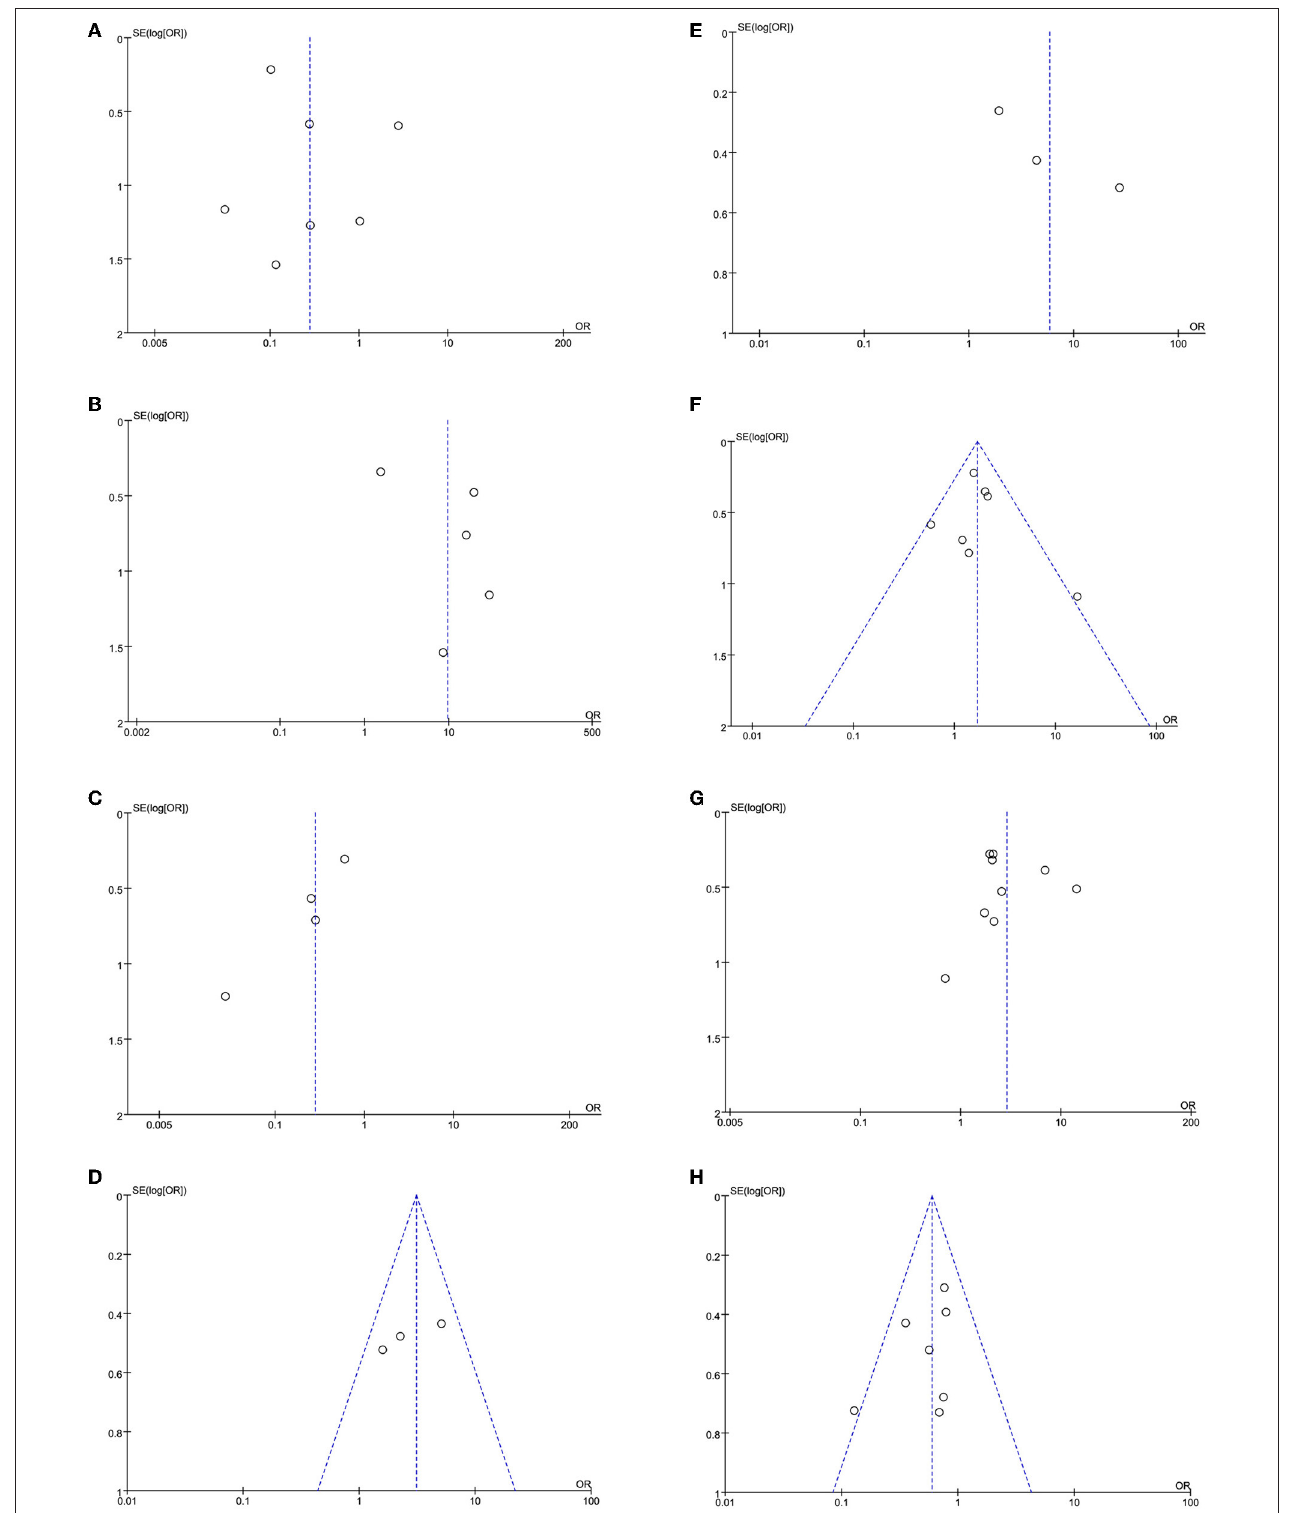
FIGURE 8 | (A) Primary angioplasty funnel plot. (B) MINOCA funnel plot. (C) Stent implantation funnel plot. (D) Baseline thrombus grade funnel plot. (E) Modified thrombus grade funnel plot. (F) Thrombus aspiration funnel plot. (G) Gp2b3a inhibitor use funnel plot. (H) TIMI-3 flow funnel plot.